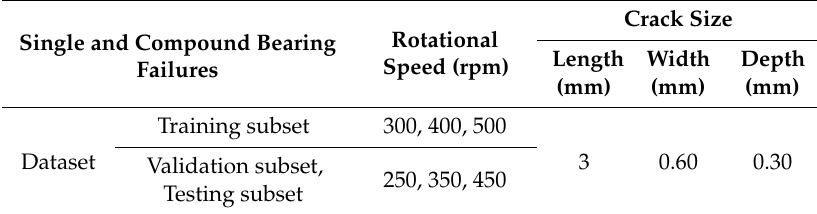
Table 1. Dataset for bearing fault diagnosis.